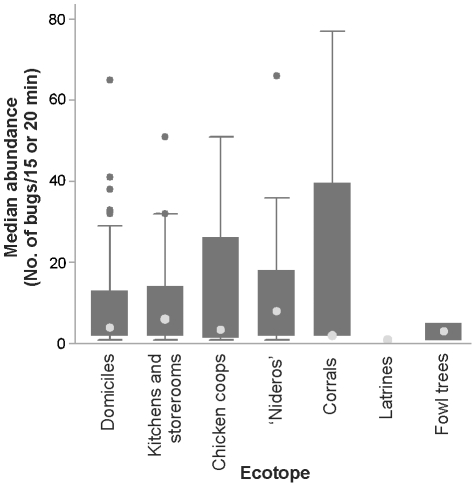
Abundance of T. infestans per site in infested sites according to their ecotope.Bug abundance determined by timed-manual collections. Light gray symbols indicate median abundance; boxes, interquartile range; whiskers, values adjacent to interquartile range; dark symbols, outside values.